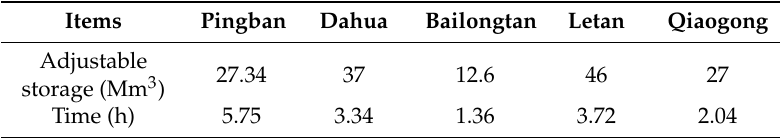
Table 2. Time required for reservoir storage from maximum to